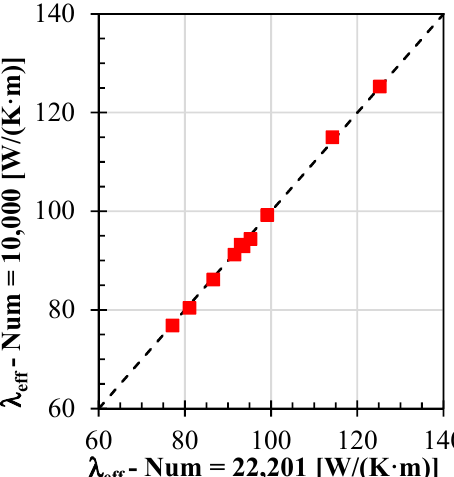
Figure 5. Comparison between results obtained with a different number of particles: 22,201 on the